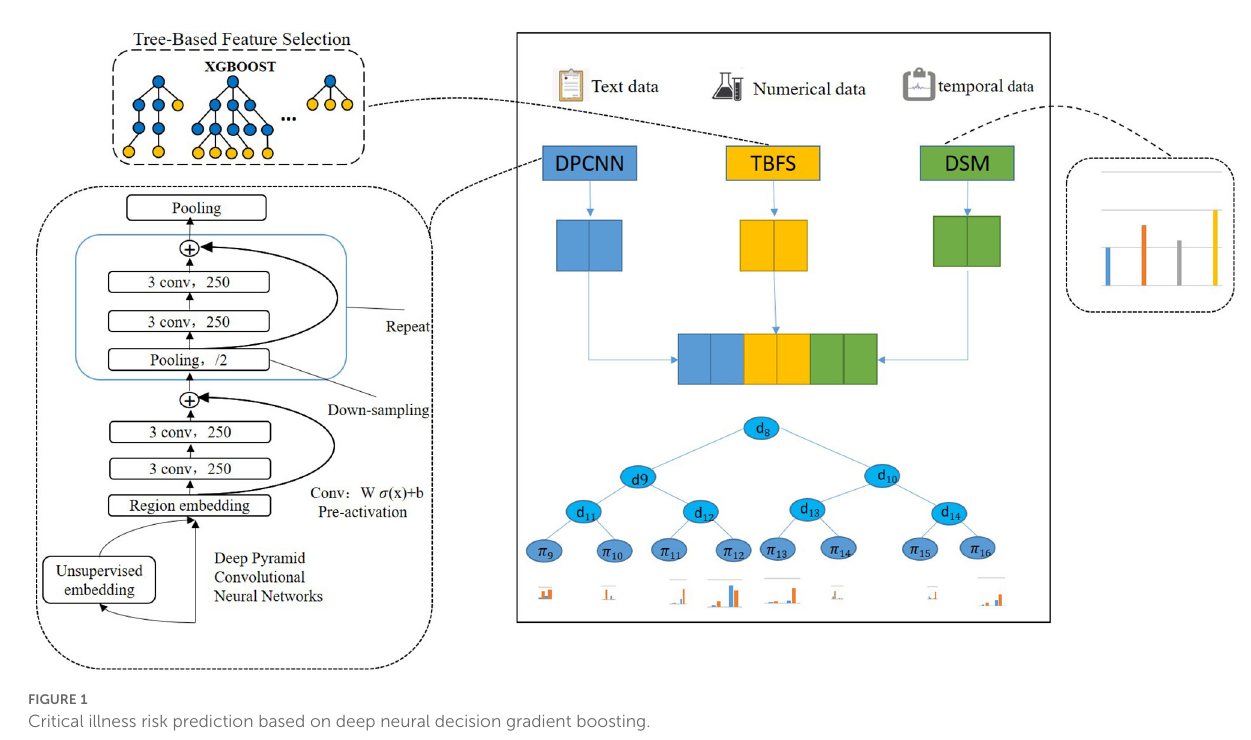
FIGURE1 Critical illness risk prediction based on deep neural decision gradient boosting.